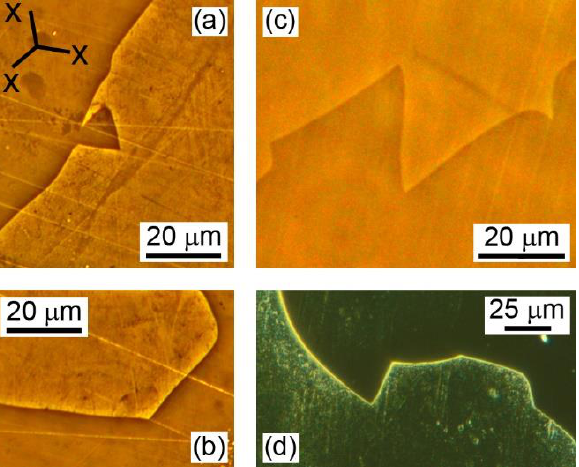
Figure 5. Optical images of as-grown domain structure in ( a – c ) 0.05% Mn-doped and ( d ) 0.1% Mn-doped CVO single crystals. Transmitted light: ( a – c ) bright field, ( d ) dark field.